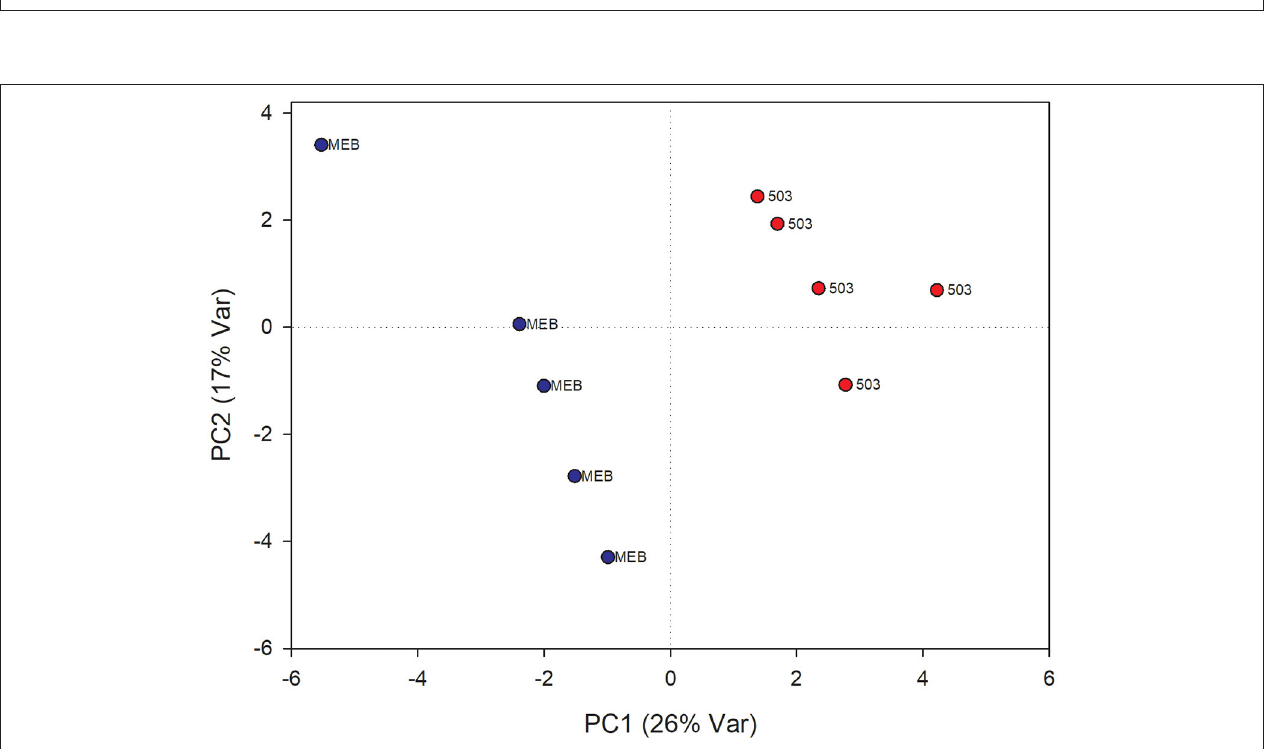
FIGURE 5 | PLS-DA score plot of NMR metabolomics data of chicory leaves extracts of MEB (control) and M. polyspora (503) groups. Blue dots indicate MEB (control) group and red dots M. polyspora group.